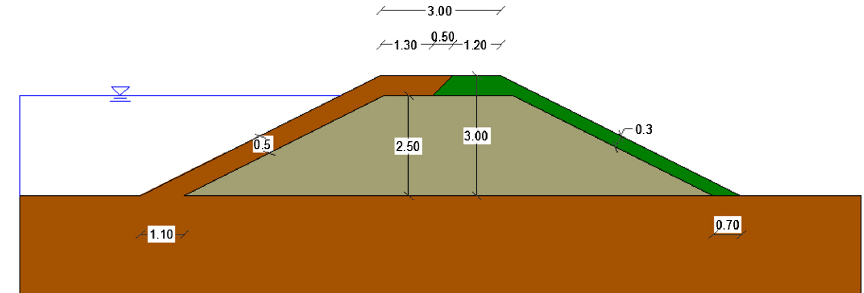
Fig. 4. Cross-section of the Gdansk research dike in the test section with the planned division of cover materials: clay (brown) on the upstream side and silt/ash composite (green) on the downstream